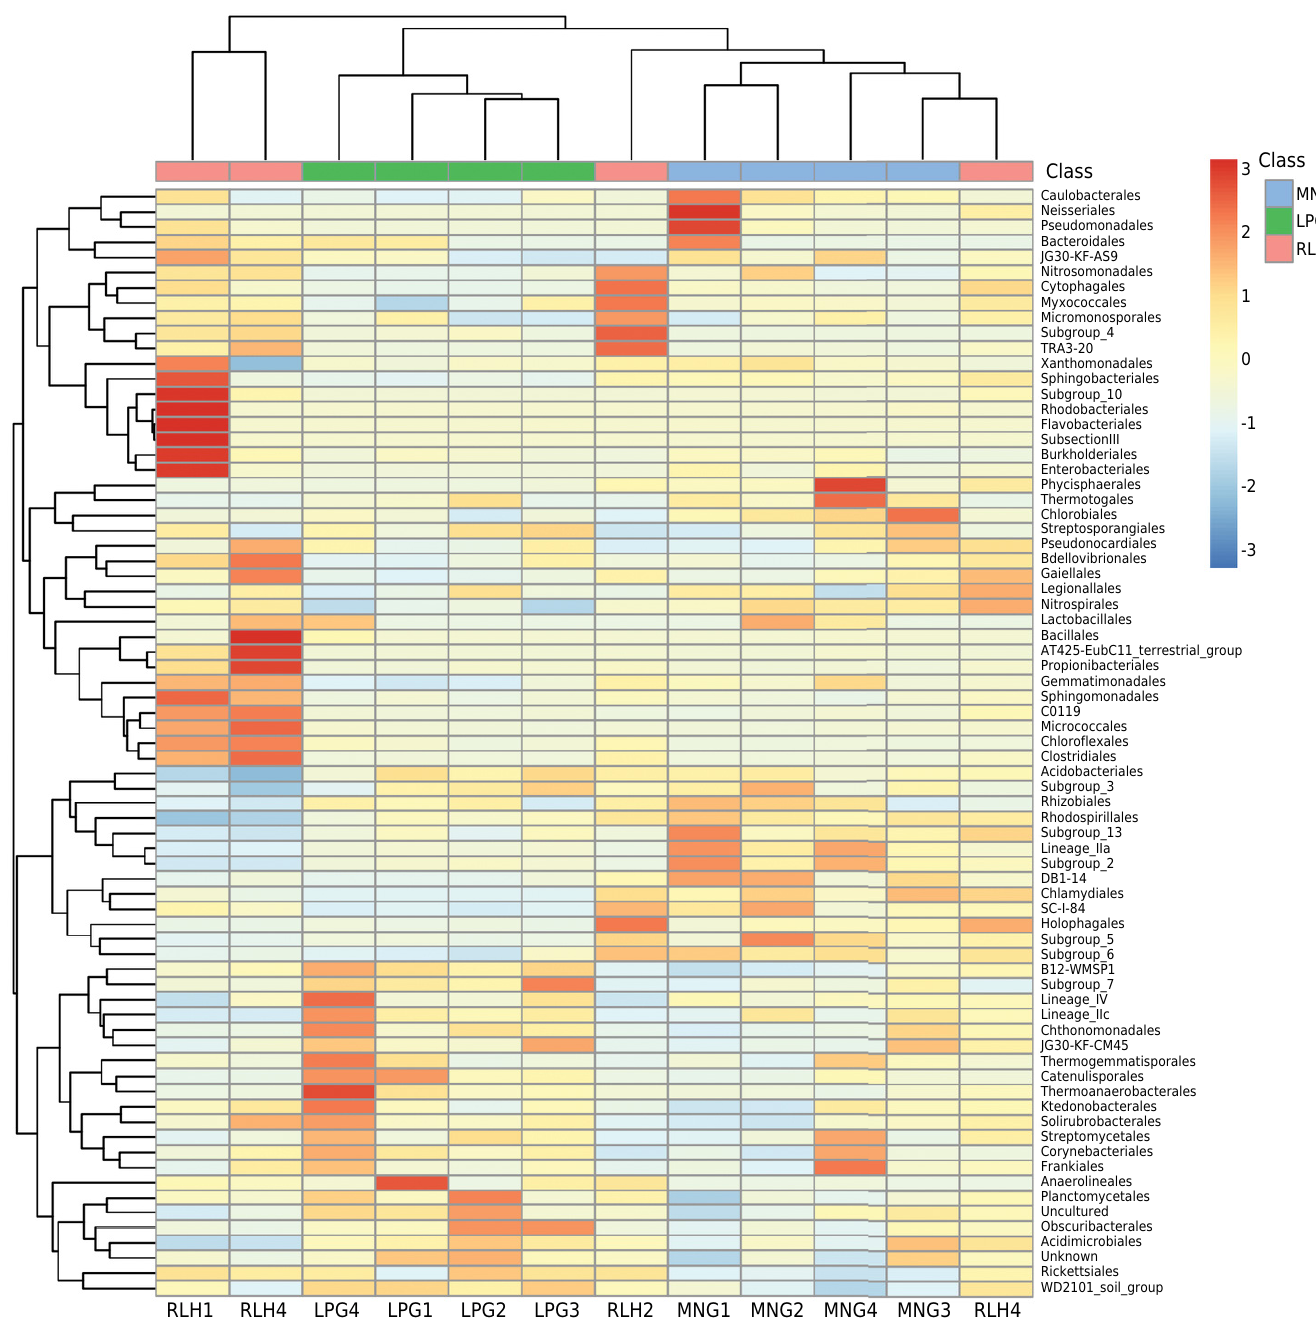
Figure 4. Heatmap analysis of the bacterial community of soil samples subjected to RLH, LPG, and MNG treatments collected at four times during the year and multiple samples similarity tree at the order level. The connecting lines on top describe the bacterial communities clustering of each sample. The connecting lines on the left side describe the clustering of each bacterium. The closer the color to red was, the more dominant microorganism was. Note: RLH: raising laying hens under forest; LPG: cultivating Lolium perenne grass under forest; MNG: maintenance of native grass under forest. The number after the treatment symbol means: 1 = spring; 2 = summer; 3 = autumn; 4 =